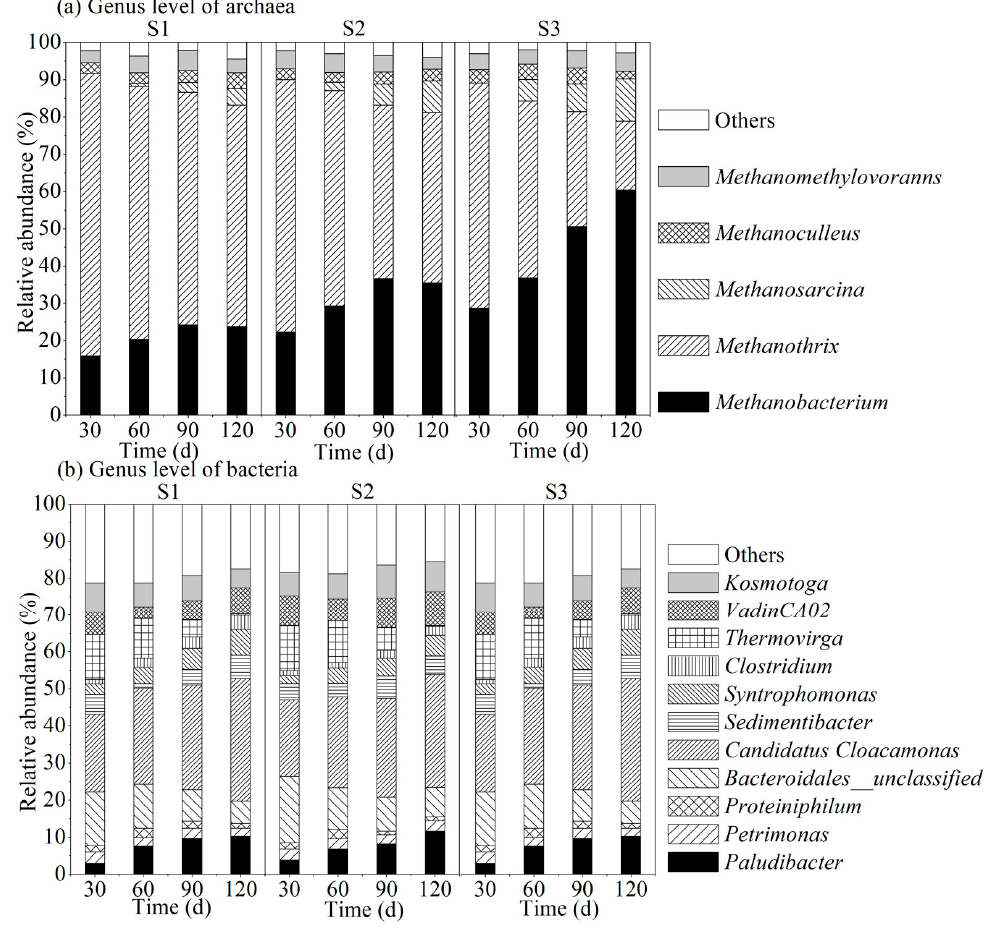
Figure 5. Relative abundance of bacterial and archaeal communities under different cycle frequencies: ( a ) genus level of archaea; ( b ) genus level of bacteria.